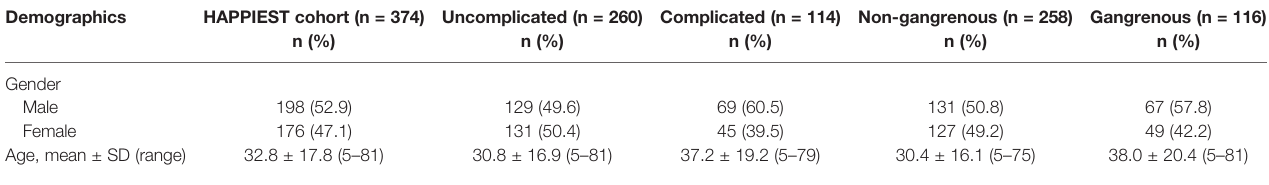
TABLE 1 | Demographics of patients in the HAPPIEST